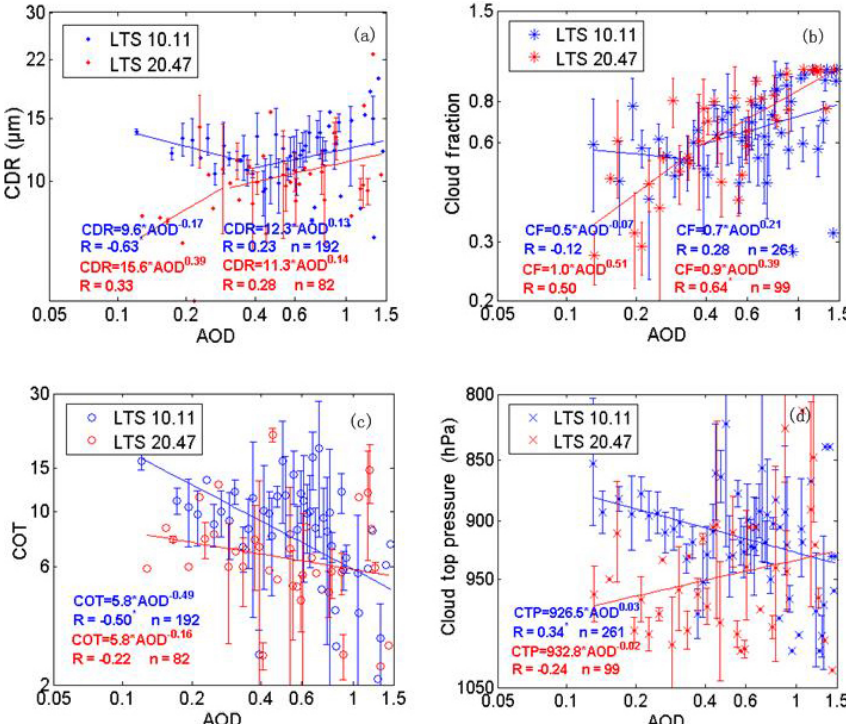
Figure 10. Scatter plots of cloud parameters versus AOD over YRD on log–log scale for cases of low LTS condition (blue) and mixed aerosol–cloud layers under high LTS condition (red): (a) CDR, (b) CF, (c) COT and (d) CTP. The lines present the least-square fits, and the resulting relations are presented in each figure. The error bars indicate the statistical uncertainties as in Fig.